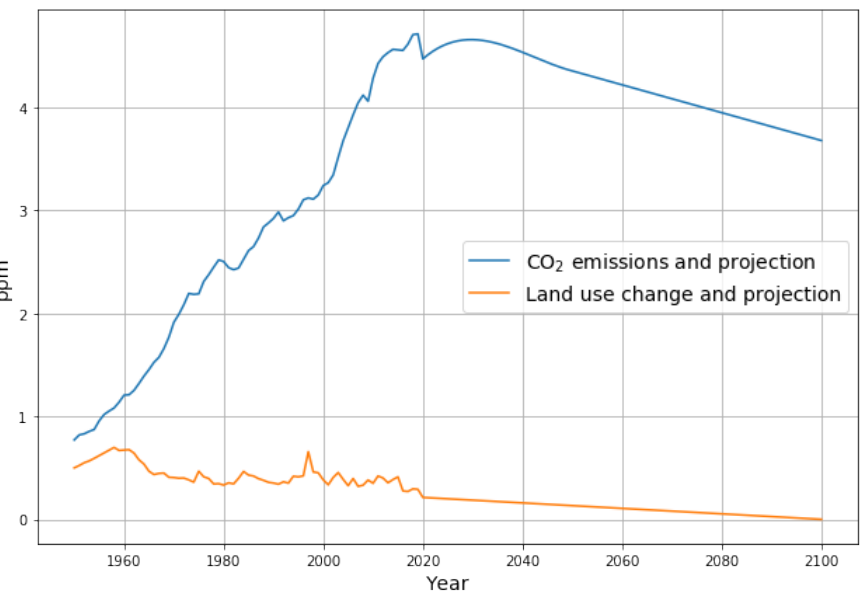
Figure 7. Emissions 1950–2020, IEA emission scenario 2021–2050, and extension to